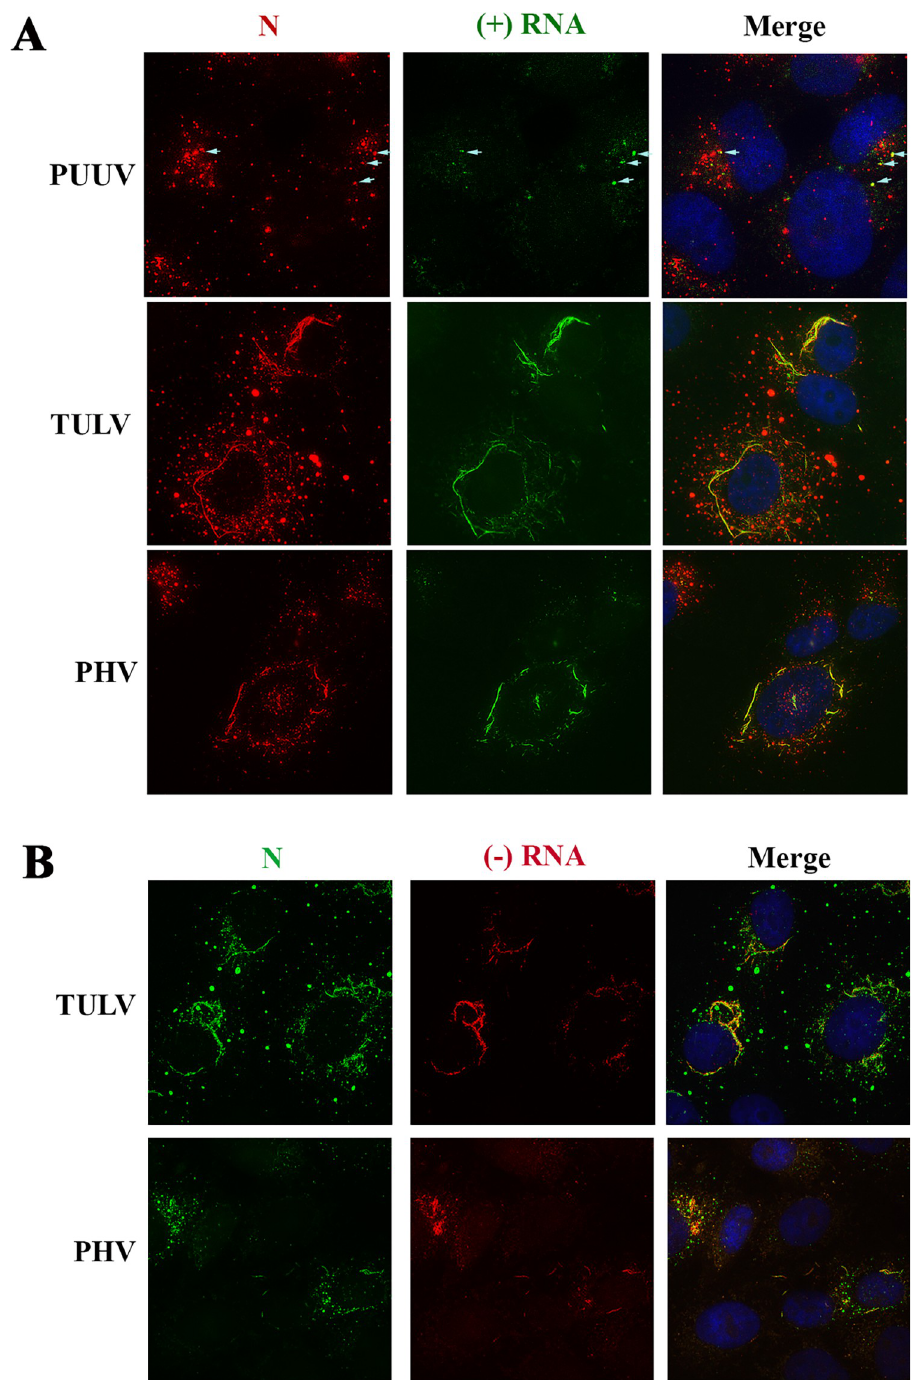
Fig 5. Co-localization of viral RNA with filamentous structures of N protein. Vero E6 cells infected with PUUV, TULV or PHV were treated for in situ hybridization by incubation with fluorescent RNA probes either complementary of the viral genomic (-)RNA (green) or of the antigenomic (+)RNA (red). The viral nucleocapsids were detected by immunofluorescence staining with the A1C5 antibody but using secondary antibodies conjugated to Alexa 555 (red) or Alexa 488 (green) according to the fluorescence of the RNA probes. Colocalization of the N filaments with viral RNA appears in yellow in the merge panels. White arrows indicate co-localisation of N dots with PUUV RNA